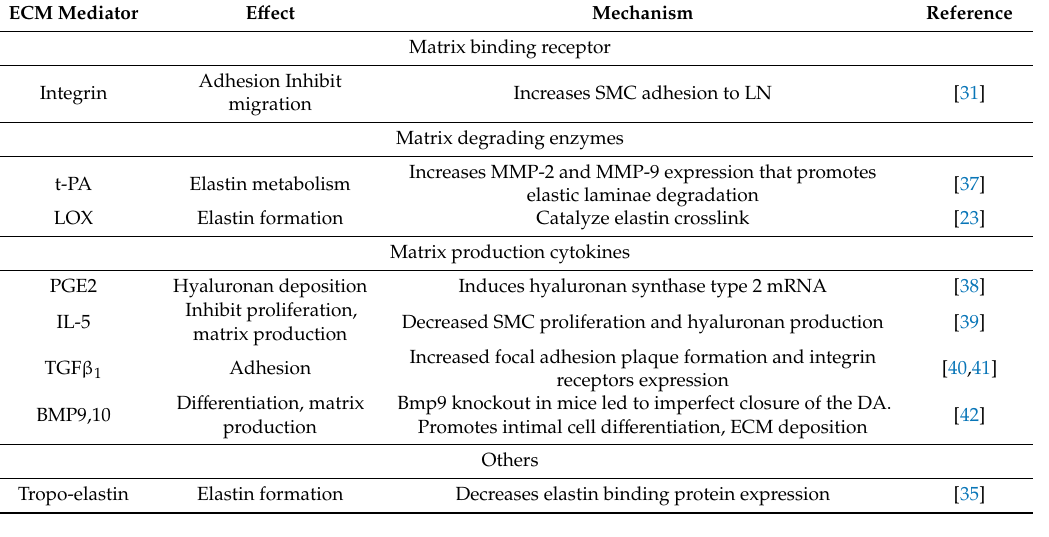
Table 4. Overview of di ff erent matrix mediators and how they may influence DA closure.